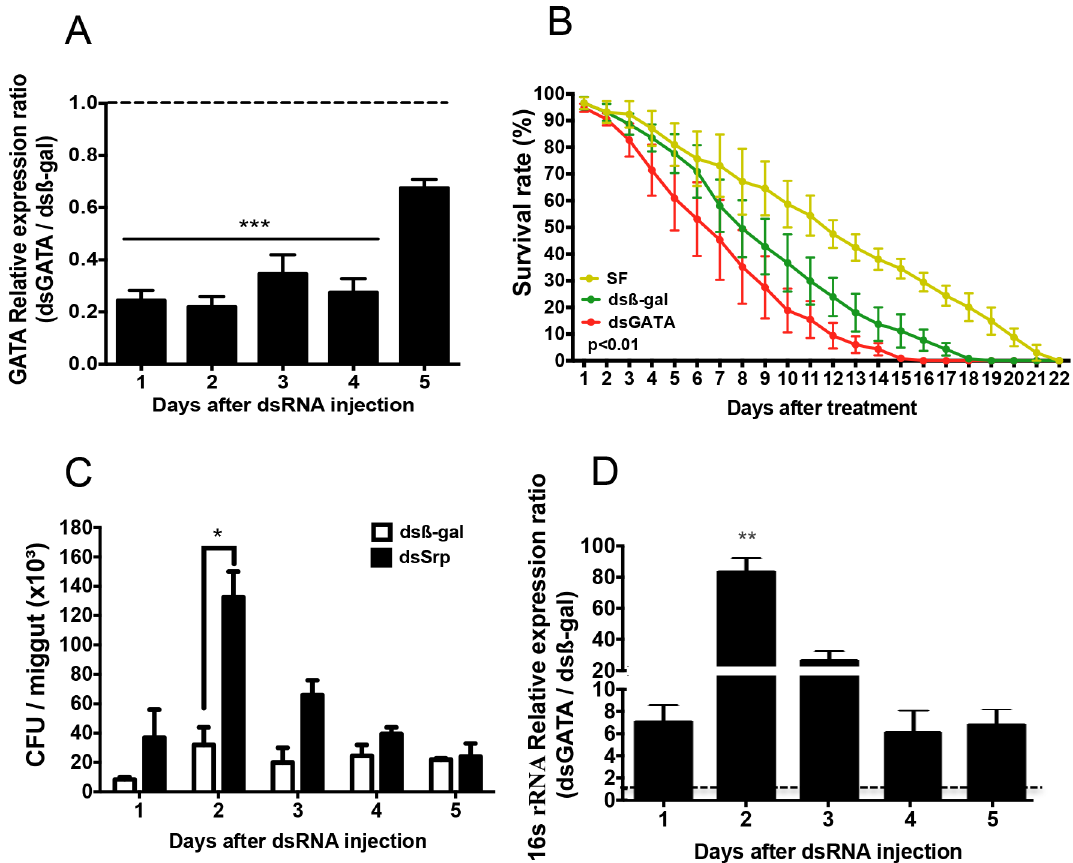
Fig 4. GATA-Serpent gene silencing in A . aquasalis . (A) Effect of dsSrp injections on GATA-Serpent and on the housekeeping RP49 gene mRNA expression. (B) Life span of mosquitoes 3–22 days after injections with dsSrp and ds β -gal (control) maintained on 10% sucrose solution. The survival rates were analyzed by Kaplan-Meier survival analysis with Wilcoxon test to determine the significance. Detailed statistical information is shown in S1 Table. Three independent experiments were performed with at least 35 mosquitoes in each group. (C-D) Evaluation of cultivable bacterial population in mosquitoes injected with ds β -gal and dsSrp. Relative quantification of 16S rRNA of culture-independent microbiota (C) and colony forming units of cultivable bacteria (D) in mosquitoes injected with dsSrp/ds β -gal. More than ten insects from three independent experiments were evaluated in C and D. 1-5d: females 1 to 5 days after dsRNA